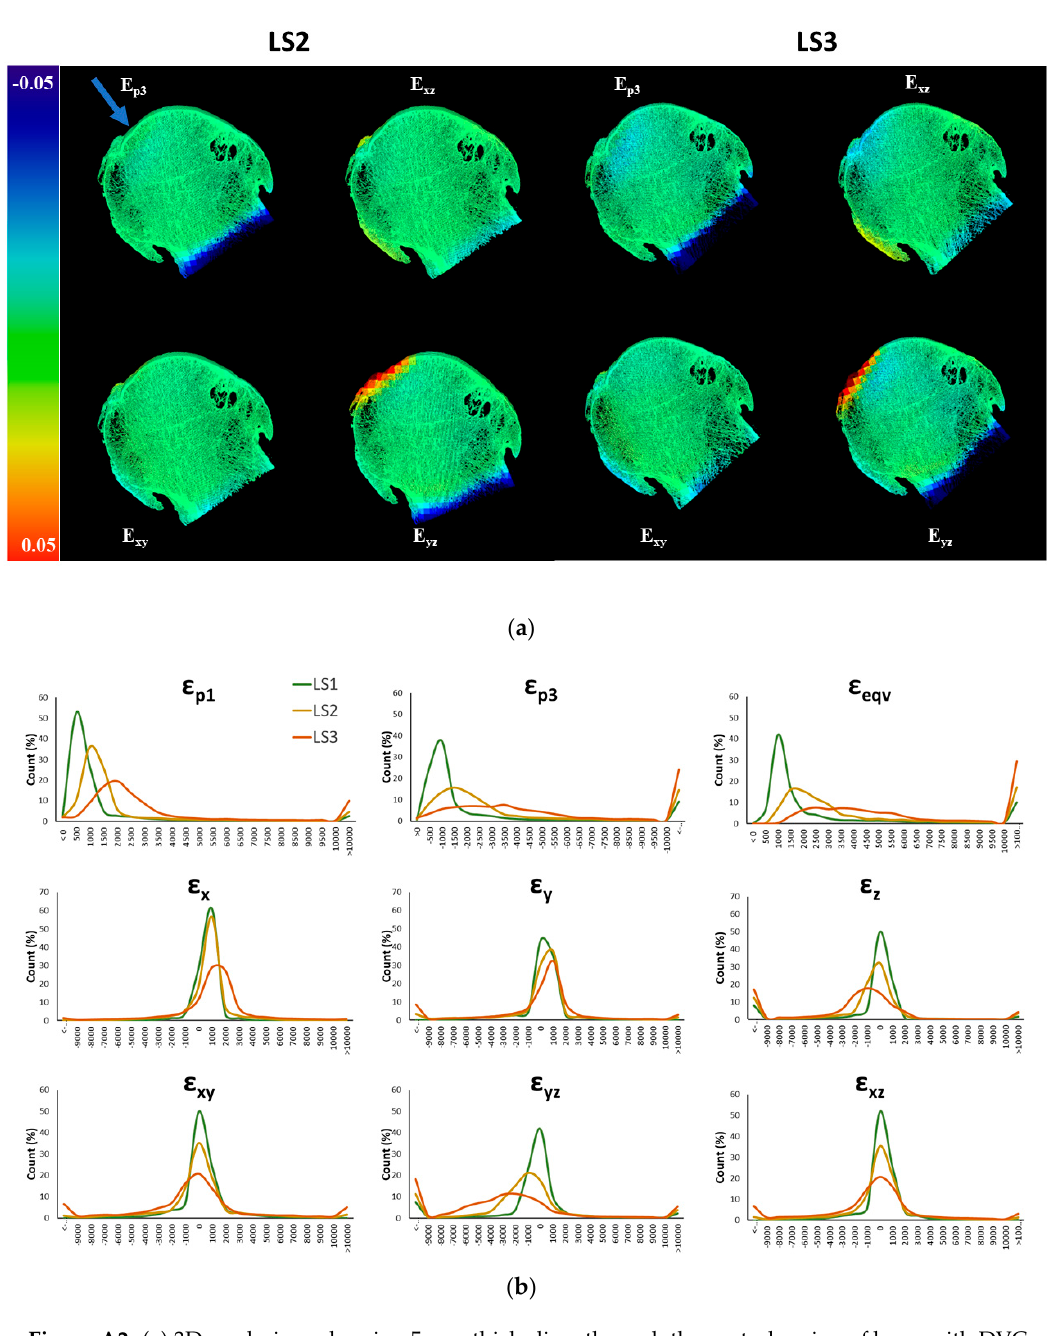
Figure A2. ( a ) 3D renderings showing 5 mm thick slices through the central region of bone with DVC output overlaid at LS2 (LEFT) and LS3 (RIGHT). The direction of applied load is indicated by the blue arrow. Strain components are noted at the top of each pictograph (TOP). ( b ) Histograms of strain distributions for each strain component ( ε p1, ε p3 ε eqv ε x ε y ε z ε xy ε yz ε xz) at the three load steps (LS1 (green), LS2 (yellow) and LS3 (orange)) (BOTTOM).